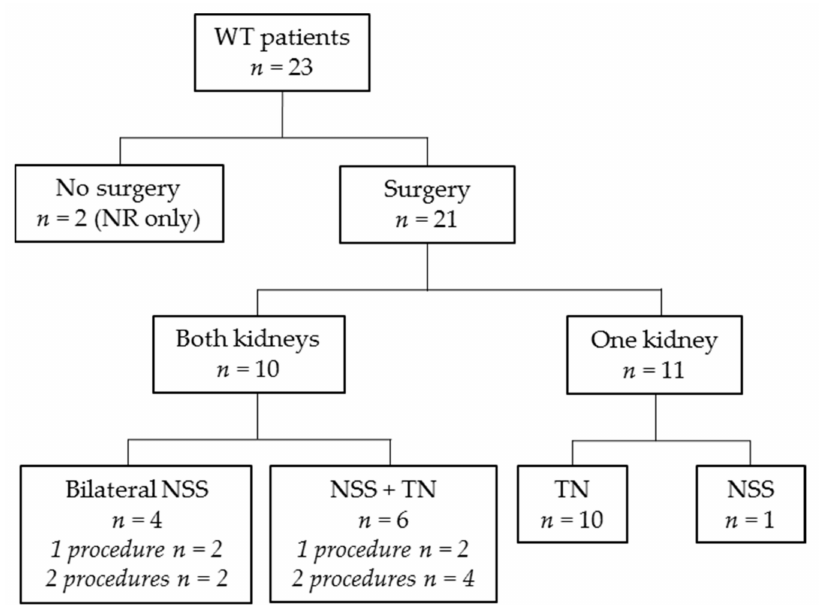
Figure 3. Flow diagram revealing applied surgery modality. WT: Wilms tumor; n: number of patients; NR: nephrogenic rests; NSS: nephron-sparing surgery; TN: tumor